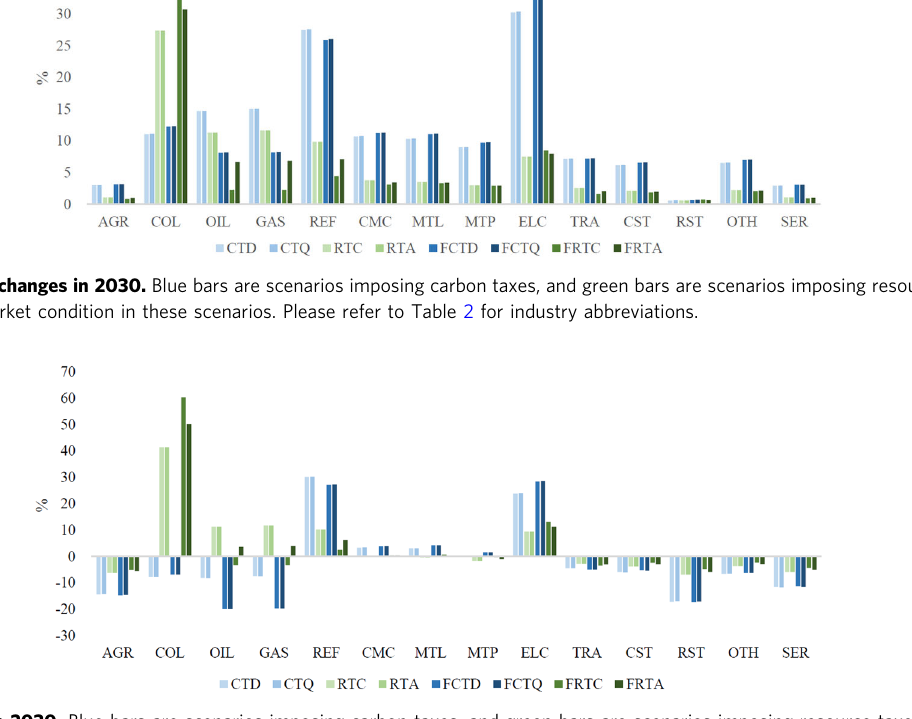
Fig. 7 Import changes in 2030. Blue bars are scenarios imposing carbon taxes, and green bars are scenarios imposing resource taxes. Deeper colors represent free market condition in these scenarios. Please refer to Table 2 for industry